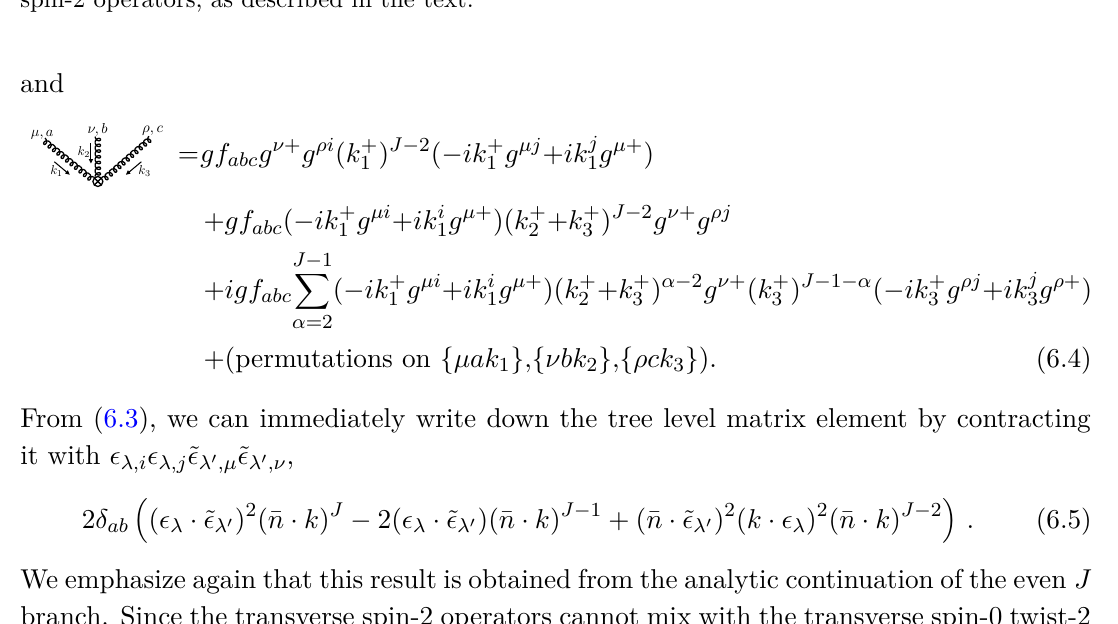
Figure 6. Feynman diagrams contributing to the one-loop anomalous dimensions of transverse spin-2 operators, as described in the